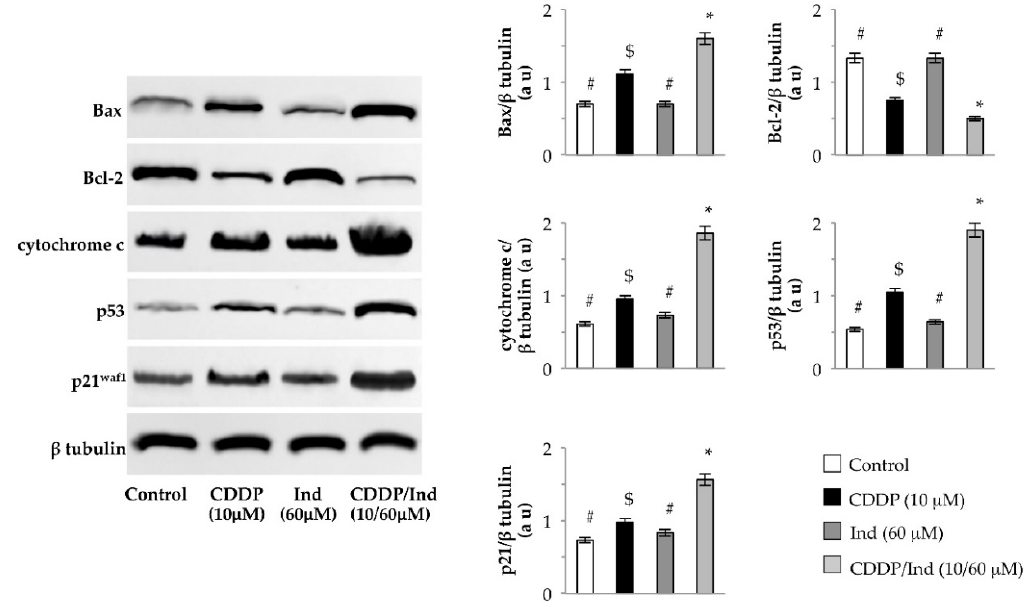
Figure 7. Effect of CDDP, Ind and CDPP/Ind on expression of apoptosis- and cell cycle-related proteins in HeLa cells. Cells were treated for 24 h as described in Methods. Representative images of immunoblotting analysis of Bax, Bcl-2, cytochrome c, p53 and p21waf1 levels and mean values ±SD of the densitometric analysis of four separate experiments. β tubulin was used as the internal control. au, arbitrary units. Bars without a common symbol are significantly different with p < 0.05 (one-way Anova associated with Tukey’s post hoc test).